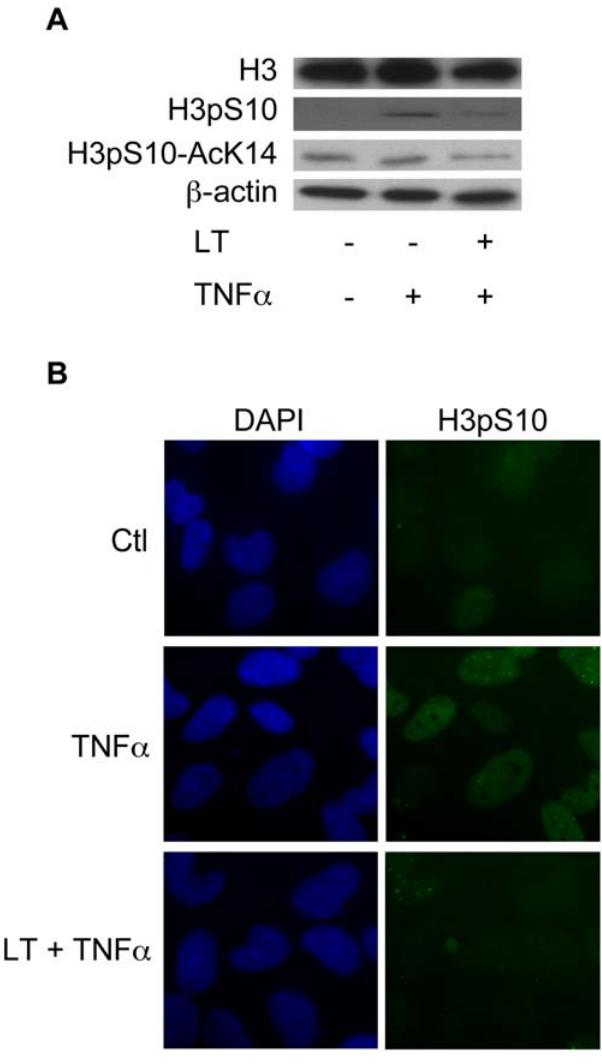
Figure 5. LT impairs H3 phosphorylation. Beas-2B cells were incubated for 1 h with LT (1 m g/ml) and stimulated with TNF a (10 ng/ ml) for an additional 2 h. Western blot analyses were performed using H3, H3pS10, and H3pS10-AcK14 antibodies and were normalized with a b -actin antibody (A). Immunofluorescence analyses were performed using an H3pS10 antibody and DAPI (B).